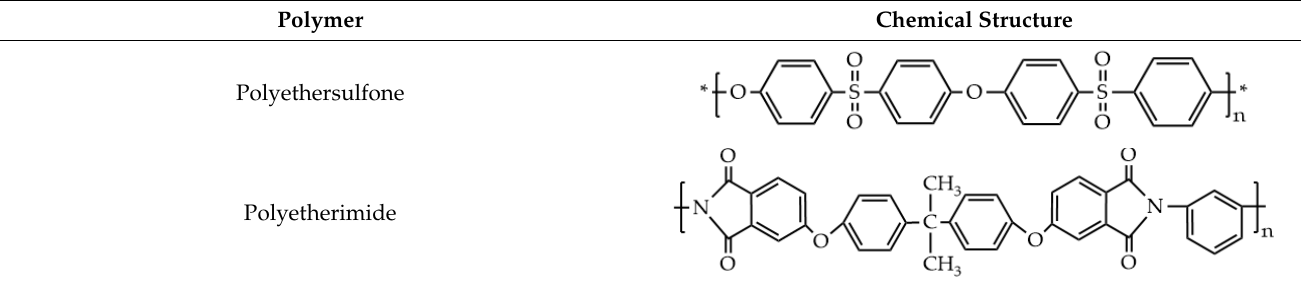
Table 1. Chemical structure of the polymer.